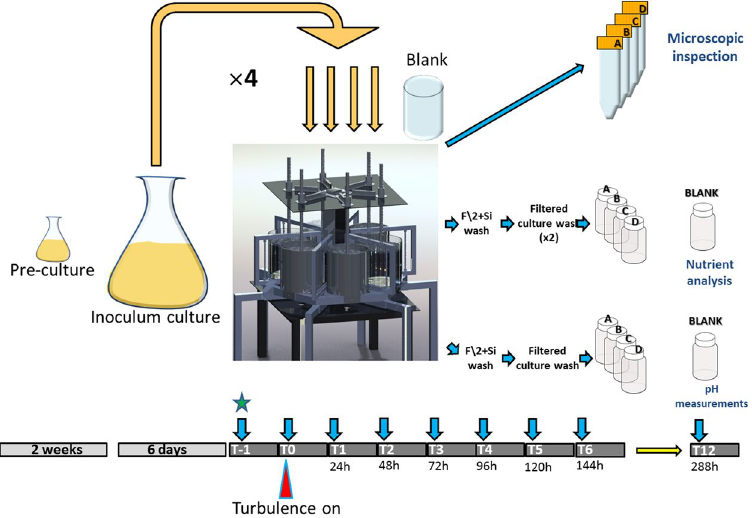
Figure 1. Graphic representation of experimental setup. Note: at T-1 (green star) samples were used for pH measurements